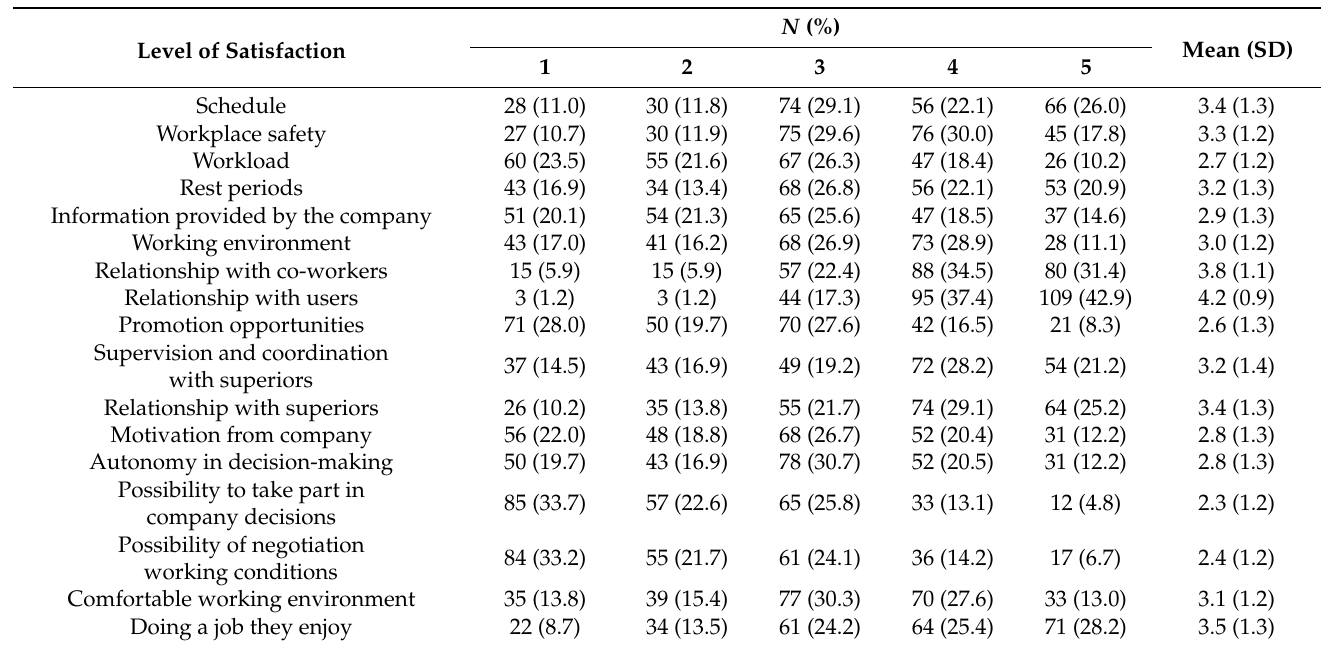
Table 3. Level of worker satisfaction.